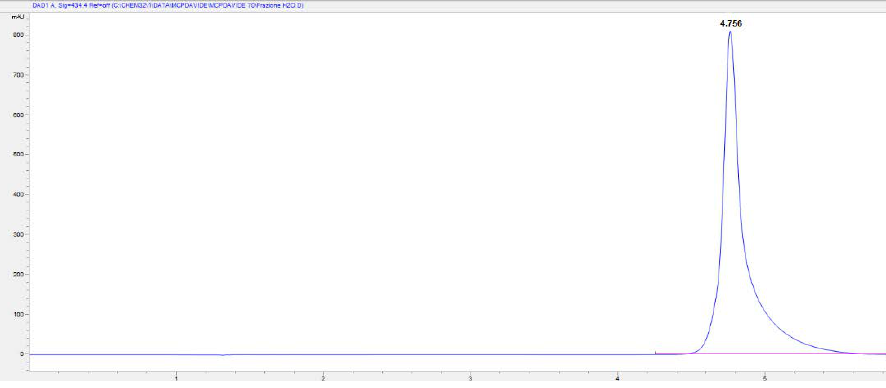
Figure 9. Chromatogram of 1.3 mM purified mCP.